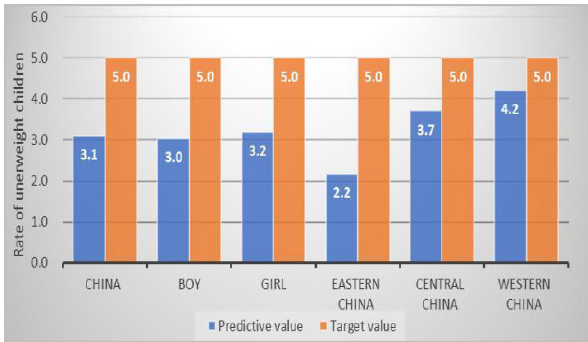
Figure 5. The estimated rate of Chinese underweight children and national nutrition target in 2020 (%).